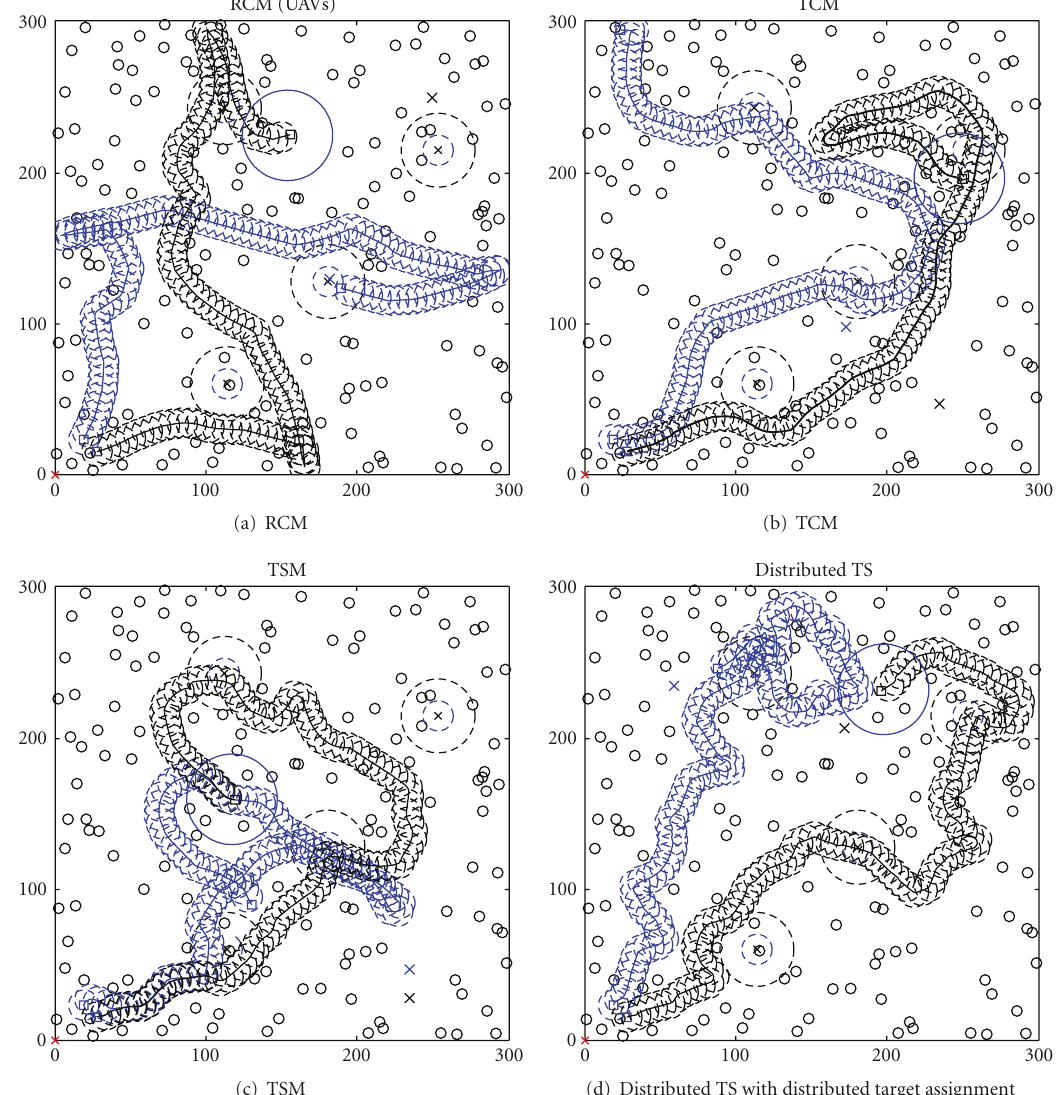
Figure 9: Paths followed for 500 moving steps using di ff erent path planning